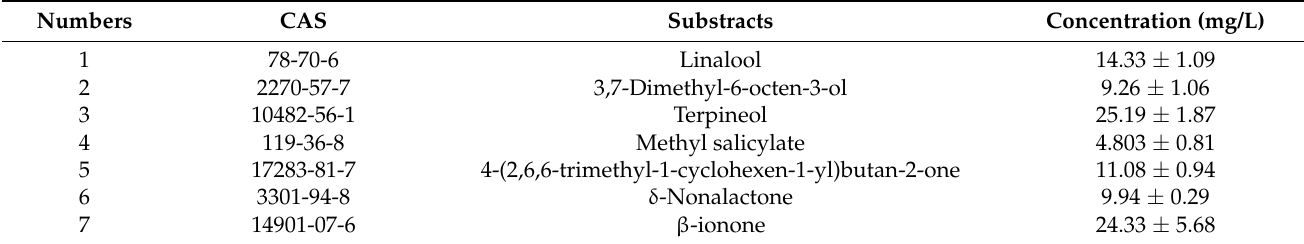
Table 1. Key Bioactive Compounds Found in the Fermentation Waste Extract.